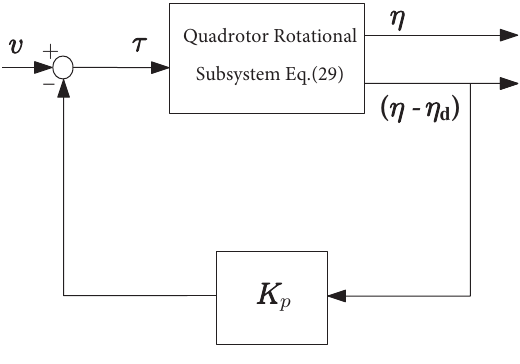
Figure 4. Inner-control